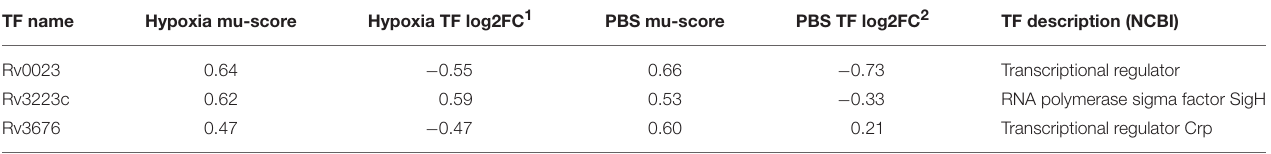
TABLE 2 | Regulons showing significant enrichment in two previously published gene expression datasets collected from a hypoxia and a PBS-starvation